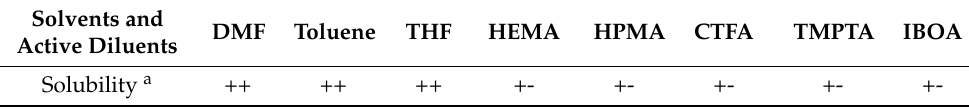
Table 2. Solubility of BDM-DDM-GMA in various organic solvents. Solvents